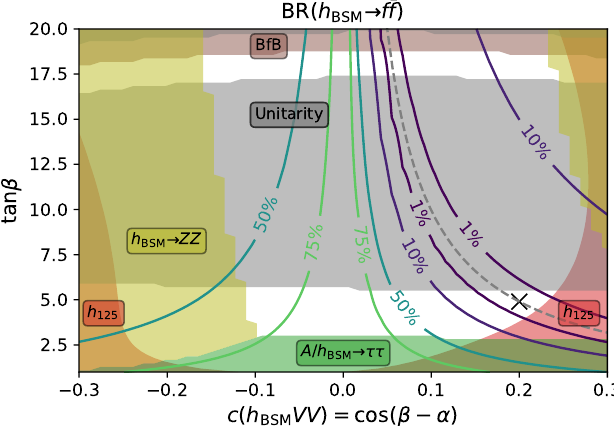
) benchmark BSM = 150 GeV and m = m = 200 GeV and all remaining h BSM A H ± ¯ f ) and the × marks BSM → f ) scenario. The dashed line denotes BSM BSM →